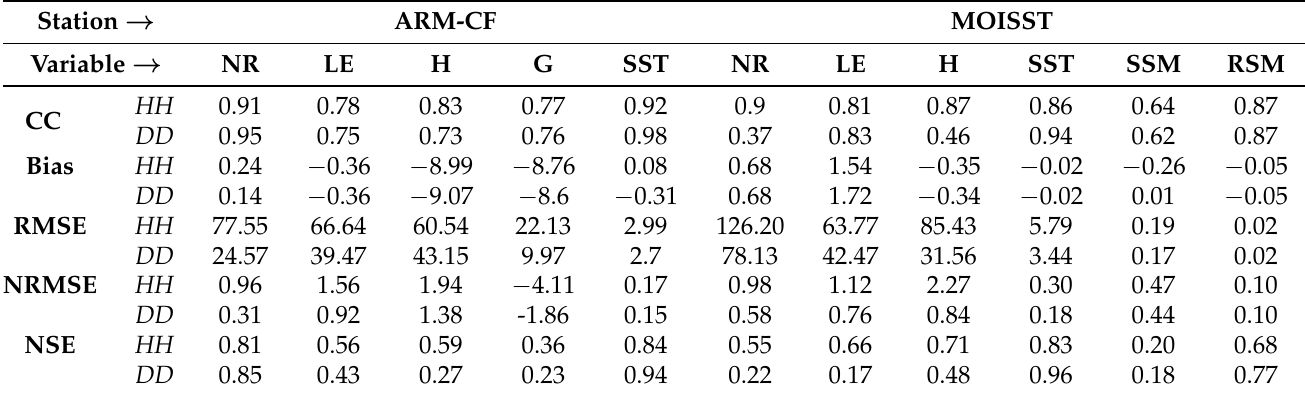
Table 8. ARM-CF and MOISST calibration metrics for each of the output variables shown in Figures 5 and 6 with respect to observed values at hourly (HH) and daily (DD) resolutions. Net radiation (NR, W/m 2 ), latent heat flux (LE, W/m 2 ), sensible heat flux (H, W/m 2 ), ground heat flux (G, W/m 2 ), soil surface temperature (SST, ◦ C), surface soil moisture (SSM, -), and root-zone soil moisture (RSM, -). The statistical metrics are correlation coefficient (CC), bias, root mean squared